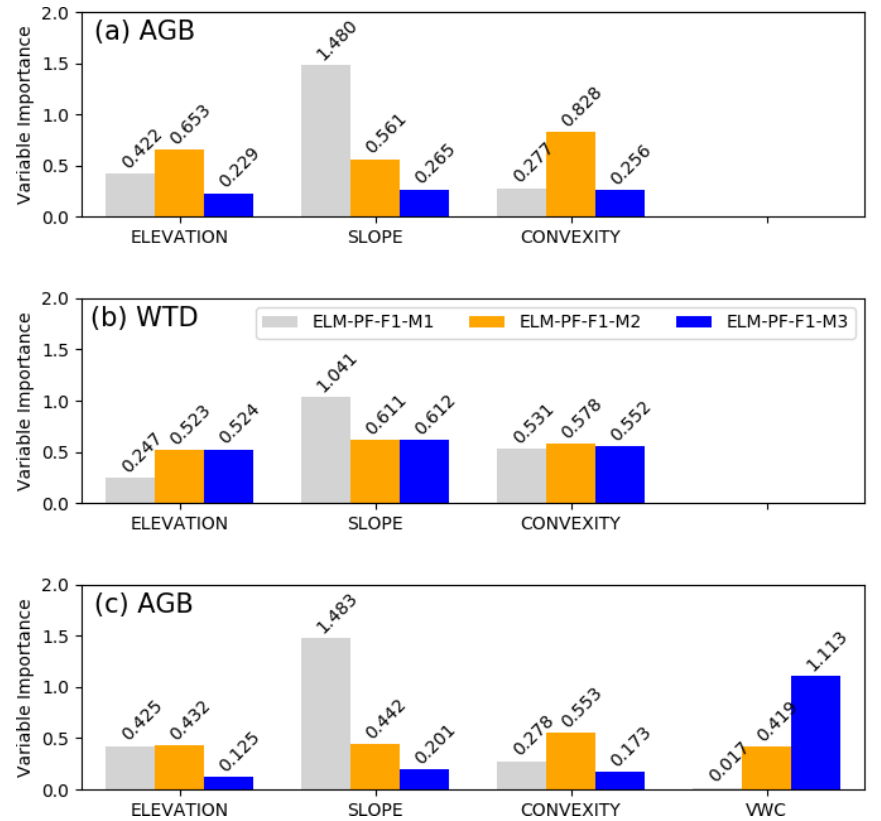
Figure 8. Variable importance for the explanatory variables ( x axis) included in the random forest model for the simulated AGB (a) and WTD (b) as response variables using elevation, slope, and convexity as explanatory variables and for the simulated AGB (c) using VWC as an additional explanatory variable in the 50ha plot. The number on top of each bar is the importance